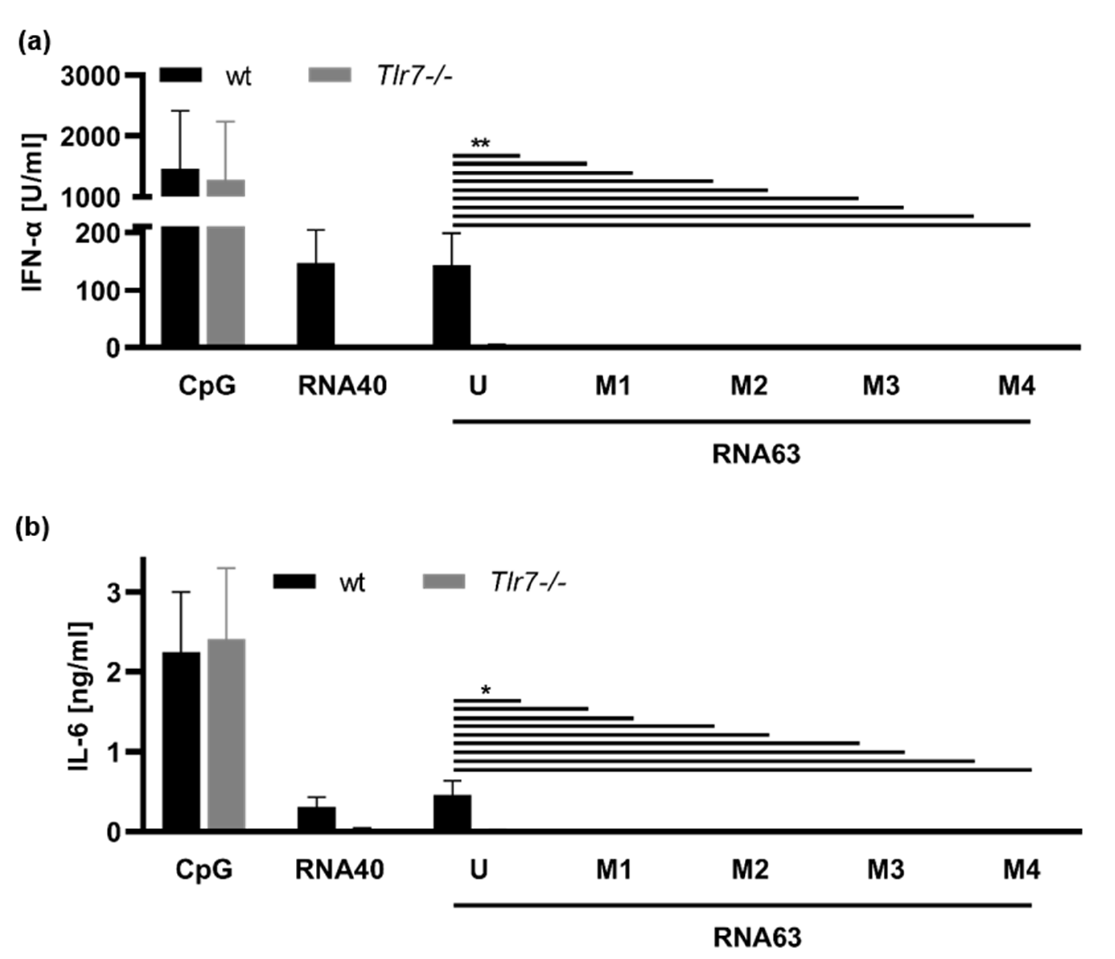
Figure 2. Methylation by 2 (cid:48) -O-ribose of a different guanosine prevents TLR7 activation. FLT3L DCs from wt or Tlr7 − / − mice were stimulated with 1 µ M CpG ODN 2216 and 5 µ g/mL RNA40 or RNA63 derivatives (U, M1, M2, M3, or M4) at a final concentration of 10 µ g/mL. Supernatants were harvested 20 h p. s. and concentrations of ( a ) IFN- α and ( b ) IL-6 were determined by ELISA. Graphs depict six independent experiments each in biological duplicates (twelve measurements per data point, mean + S.D). Data were analyzed using Wilcoxon tests. ** p < 0.01, * p <